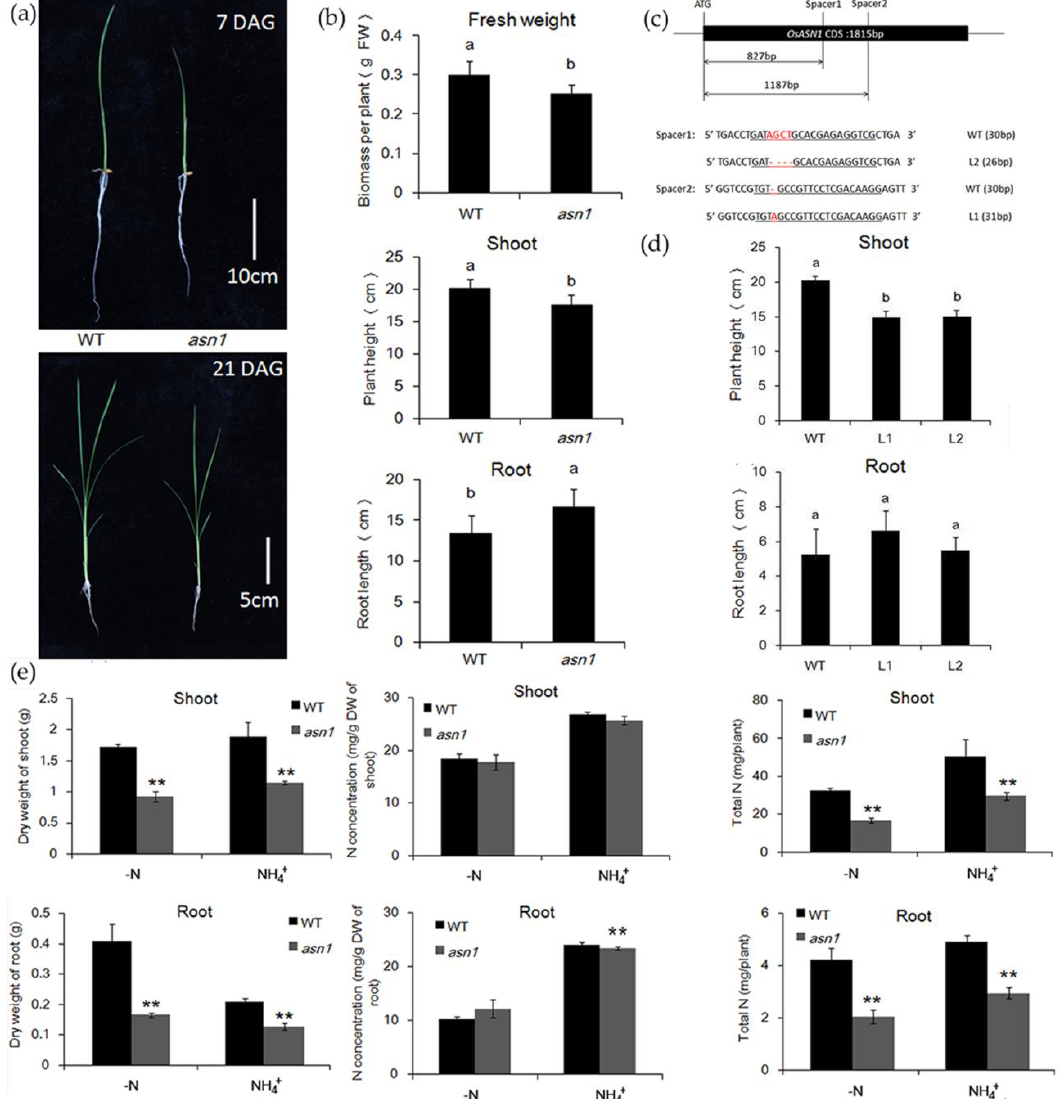
Figure 2. Phenotypic analysis of asn1 . ( a ) Seven- and 21-day-old seedlings of wild type (WT) and asn1 , DAG, days after germination; ( b ) fresh weight (FW), shoot, and root length of WT and asn1 when fifth leaf fully expanded, data are mean ± SD ( n ≥ 8) , means with different letters were significantly different; ( c ) information of mutants generated by CRISPR/Cas9 system, the underline indicates the position of spacers and the red color highlights the mutation positions; ( d ) root length and height of WT and line 1 (L1), line 2 (L2). Data are mean ± SD ( n ≥ 3), means with different letters were significantly different; ( e ) dry weight (DW), nitrogen concentration, and total nitrogen of WT and asn1, with and without 2.5 mM NH 4 + , for three weeks after one-month pre-culture. Data are means ± SD ( n = 5). Significant differences were determined by ANOVA (** p < 0.01).